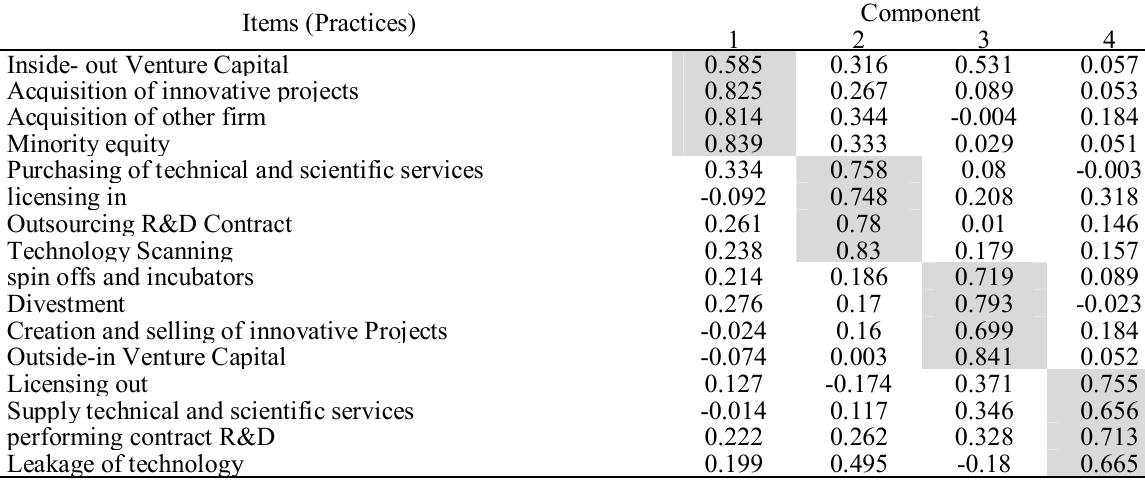
Rotated Component Matrix Items